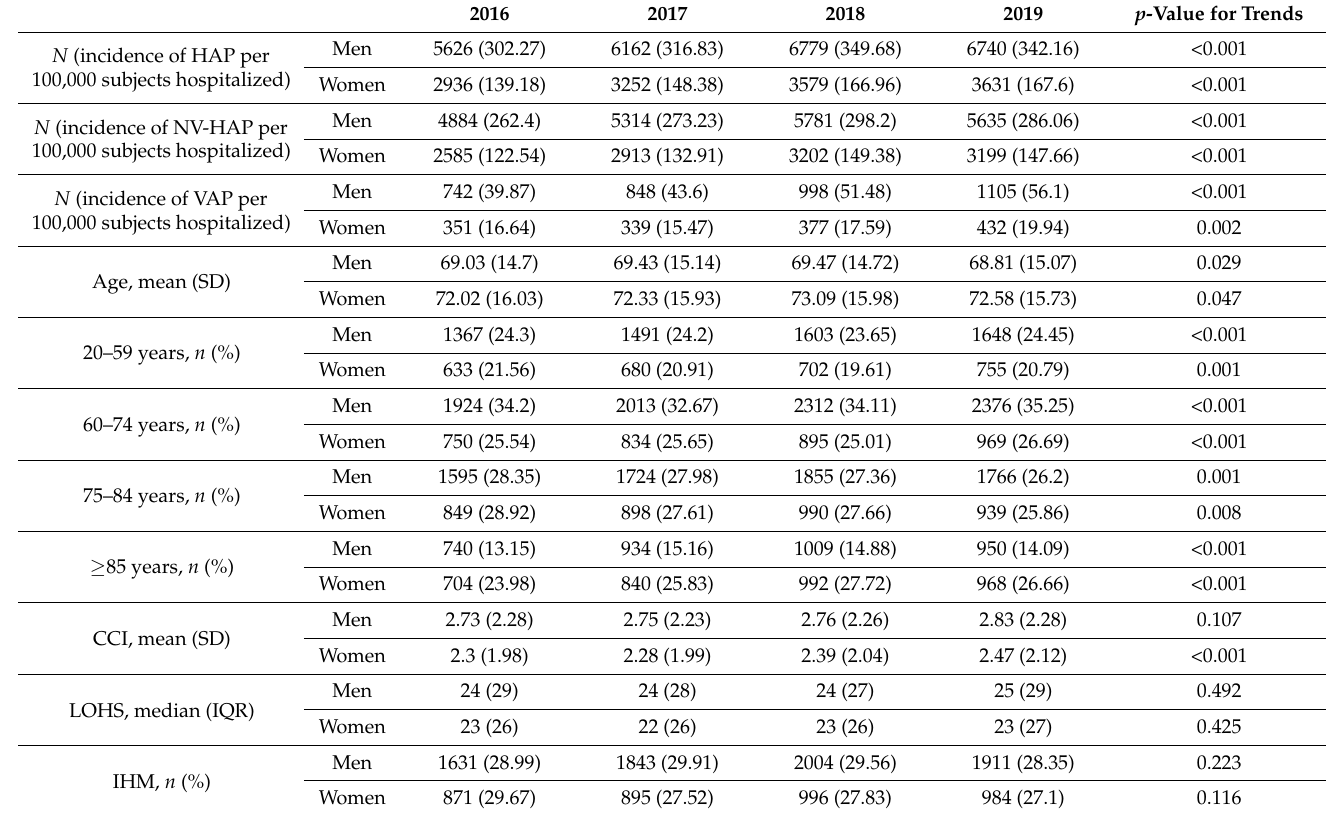
Table 2. Incidence, clinical characteristics and in-hospital outcomes of patients who developed hospital-acquired pneumonia (HAP) in Spain from 2016 to 2019 according to